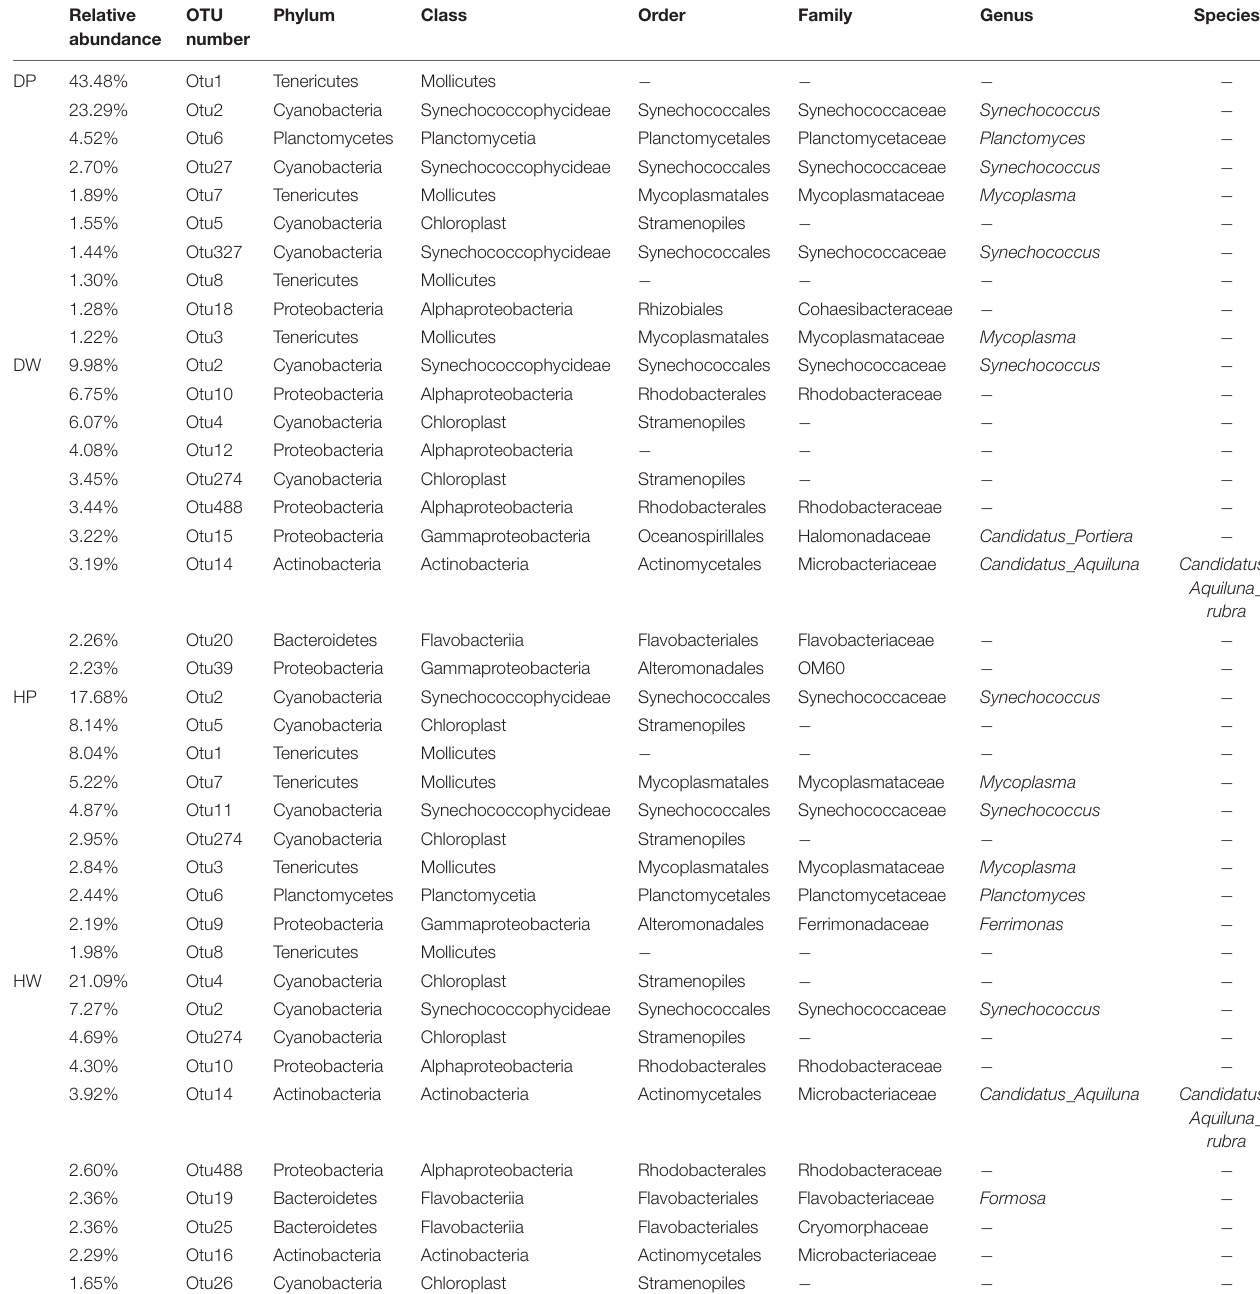
TABLE 1 | Top 10 abundant OTUs in DP, DW, HP, and HW. Relative OTU abundance number